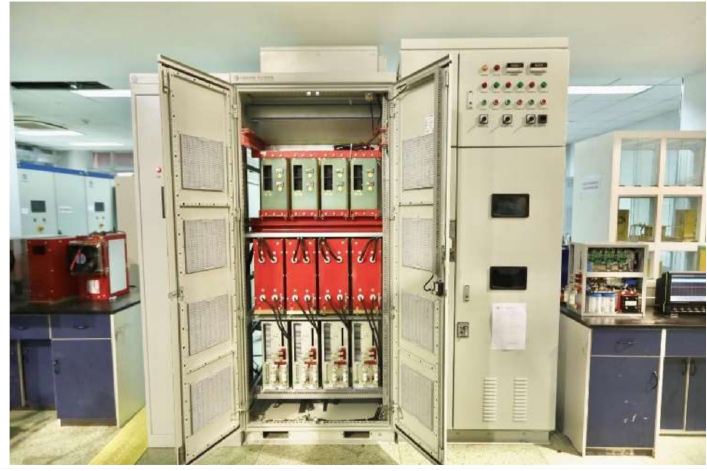
Figure 19. ± 10 kV/200 kW SiC PV MVDC